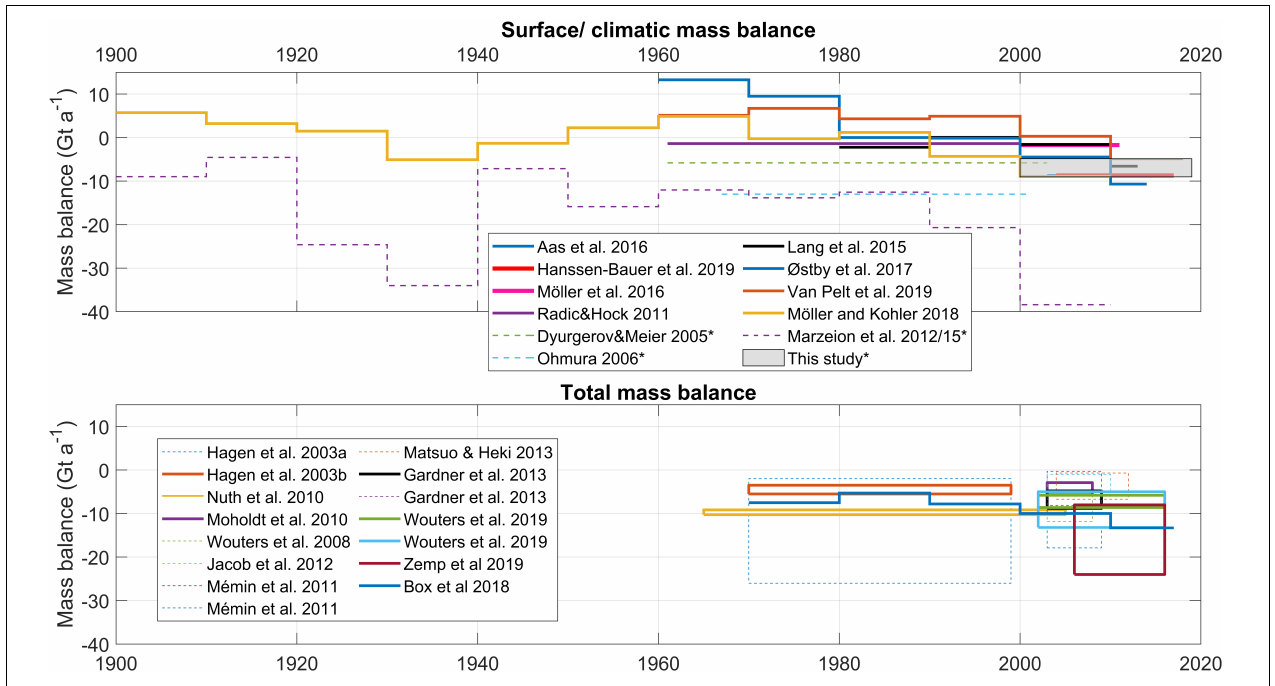
FIGURE 3 | Overview over different estimates of Svalbard glacier mass balance illustrating the period of coverage and related uncertainties of individual studies. The top panel shows estimates of surface mass balance and climatic mass balance, derived from upscaling of available in situ records and model simulations, respectively. Our new SMB estimate based on size-specific upscaling of measurements is shown as a gray box. The asterisks in the legend mark those estimates that refer to SMB whereas the others refer to CMB. The bottom panel illustrates estimates of total mass balance, based on geodetic and gravimetric methods. Most GRACE studies published two different estimates based on different processing of the underlying gravimetry data. Line styles indicate agreement with criteria defined in the text (solid = included in reconciliation, dashed = not included).